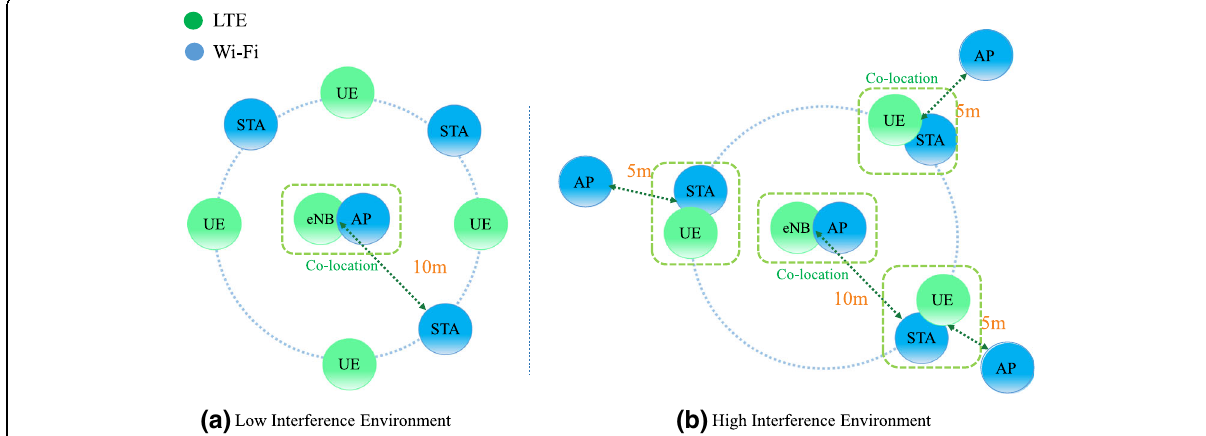
Fig. 6 Simulation environments. a Low interference environment. b High interference